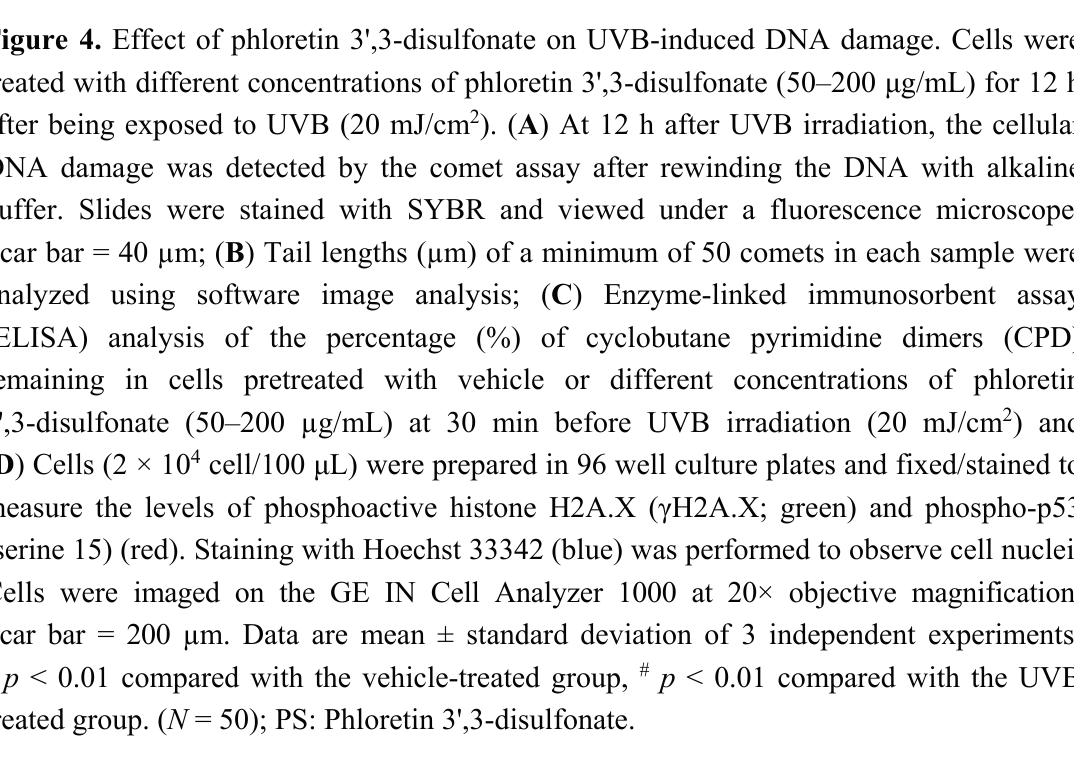
Figure 4. Effect of phloretin 3',3-disulfonate on UVB-induced DNA damage. Cells were treated with different concentrations of phloretin 3',3-disulfonate (50–200 μ g/mL) for 12 h after being exposed to UVB (20 mJ/cm 2 ). ( A ) At 12 h after UVB irradiation, the cellular DNA damage was detected by the comet assay after rewinding the DNA with alkaline buffer. Slides were stained with SYBR and viewed under a fluorescence